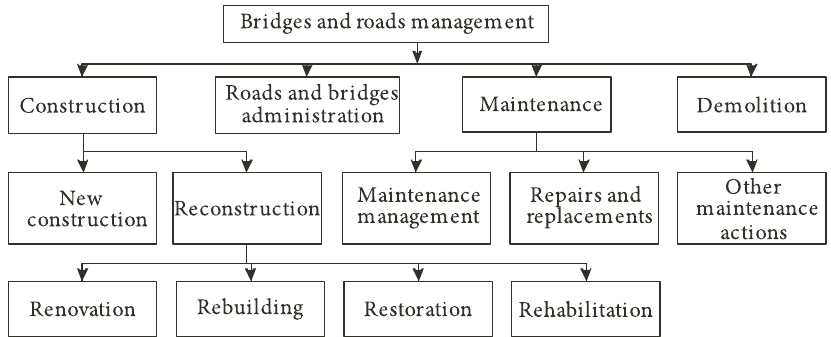
Fig. 2. Concepts of bridges and roads management and